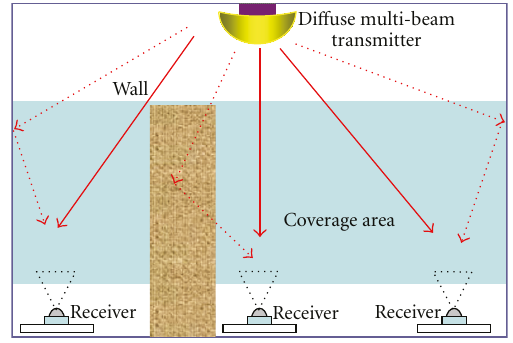
Figure 2: Geometry of optical source model with Lambertian radiation pattern and receiver